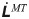
Proposed NC model for human stance postural control.u, uff, and ufb are the total, ff, and fb controls, respectively; τfb, τtrans, and τact are the feedback, transmission, and activation dynamics delay, respectively. LMT and L˙MT are the length and lengthening velocity of the muscular-tendon actuator, respectively. LM and L˙M are the length and lengthening velocity of the muscle fiber, respectively. a indicates the muscle activation, kp and kd are the fb gains, and L0MT and L˙0MT are the muscular-tendon actuator length and lengthening velocity for the objective posture, respectively. Each of the symbols listed above represents a 70-dimensional vector.